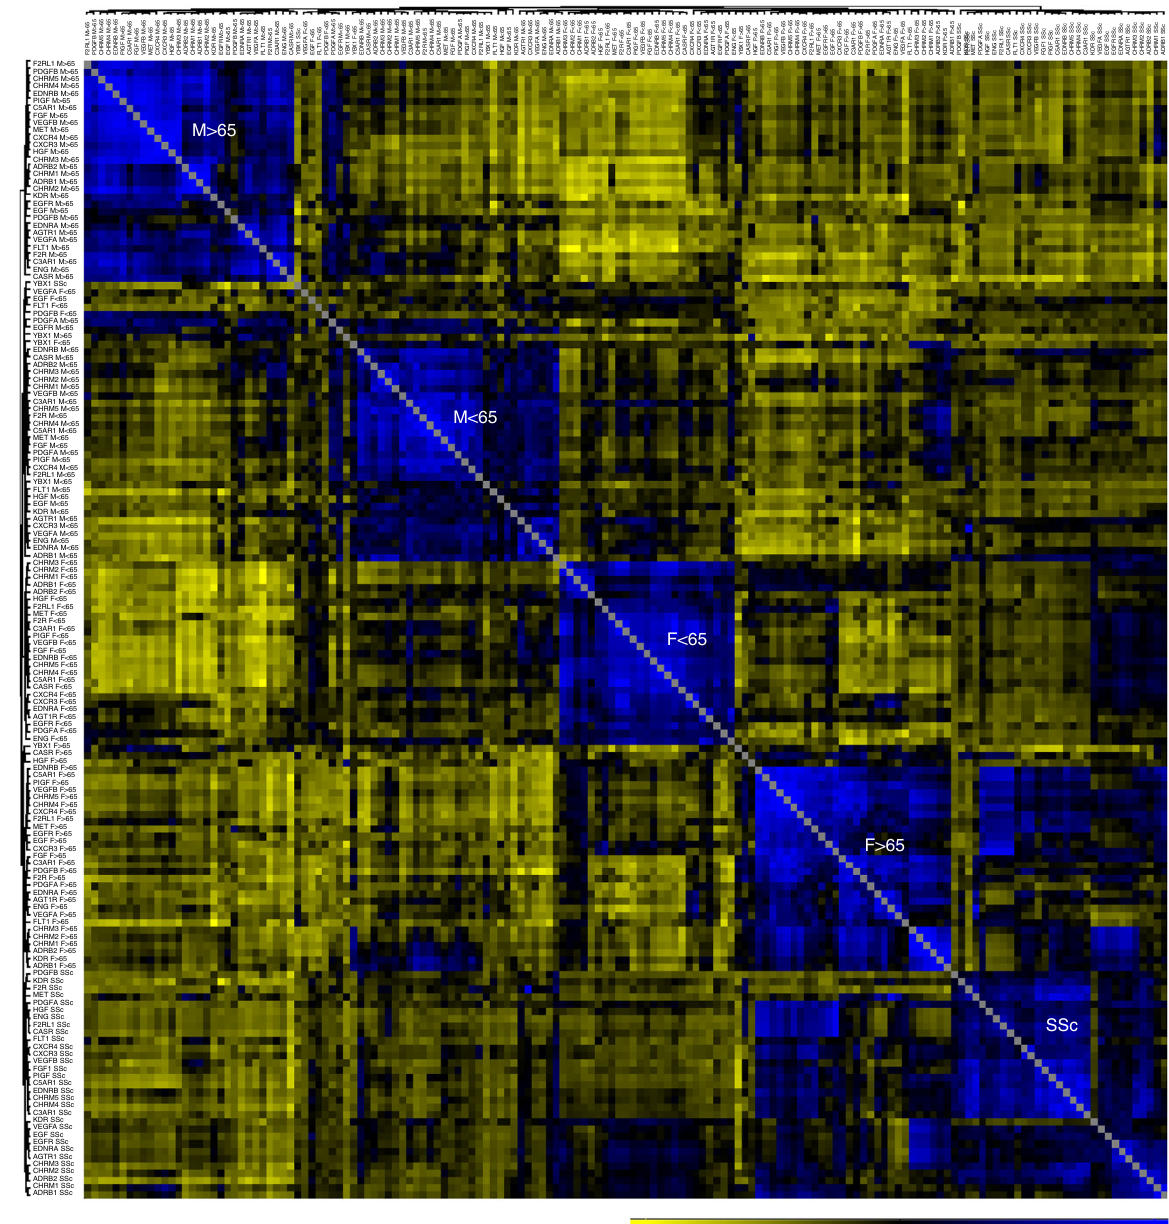
Fig. 6 Hierarchical clustering of the autoantibody correlation signature. Correlogram matrix displays clusters (modules) of autoantibody (aab) correlations in all healthy donors (HD) according to gender and age (< and ≥ 65 years old) compared with patients with systemic sclerosis (SSc; Supplementary Table 1, cohort 1; Supplementary Table 2, aab dataset 1). Clusters of the correlations among aab are displayed in dendrograms on the top and side of the correlation matrix. The bar ranging from yellow to blue ( − 0.6 to 0.9) represents negative to positive correlations, respectively. In the heat map matrix, each small square represents the pairwise correlations between aab. The correlation matrix used to perform the hierarchical correlogram of SSc is provided as source study. Sera from SSc patients were provided by members of the Department of commercially available solid-phase sandwich ELISA Kits according to the manu- Rheumatology at the University of Lübeck and the University Hospital Charité in facturer ’ s instructions (all CellTrend GmbH, Luckenwalde, Germany). The aab Berlin; the AD patients are being cared for by three participating Norwegian concentrations were calculated as arbitrary units (U) by extrapolation from a centers (Rogaland and Hordaland counties and the dementia study in Western standard curve of fi ve standards ranging from 2.5 to 40U/ml. The ELISAs were Norway). Sera from OC patients were provided by Prof. Jalid Sehouli, Department validated according to the Food and Drug Administration ’ s Guidance for Industry: of Gynecology, the University Hospital Charité in Berlin, corporate member of Bioanalytical Method Validation. which was performed in accordance with the Declaration of Helsinki and approved Aab interaction network . Statistical and bioinformatics analyses of the obtained by the ethics committees of the involved research centers. aab data were performed using the free, open-source software package R 58 . The R packages are described in the Reporting Summary. We used circle plot diagrams to visualize the patterns of Spearman ’ s rank correlation coef fi cients between aab and Aab detection by ELISA . The methods to measure the aab have been previously the Gini index coef fi cient 26 to assess the distribution patterns of aab concentra- described in detail 15,25 . Brie fl y, individual serum aab were assessed using tions. In addition, LDA of aab signatures was performed as previously described to